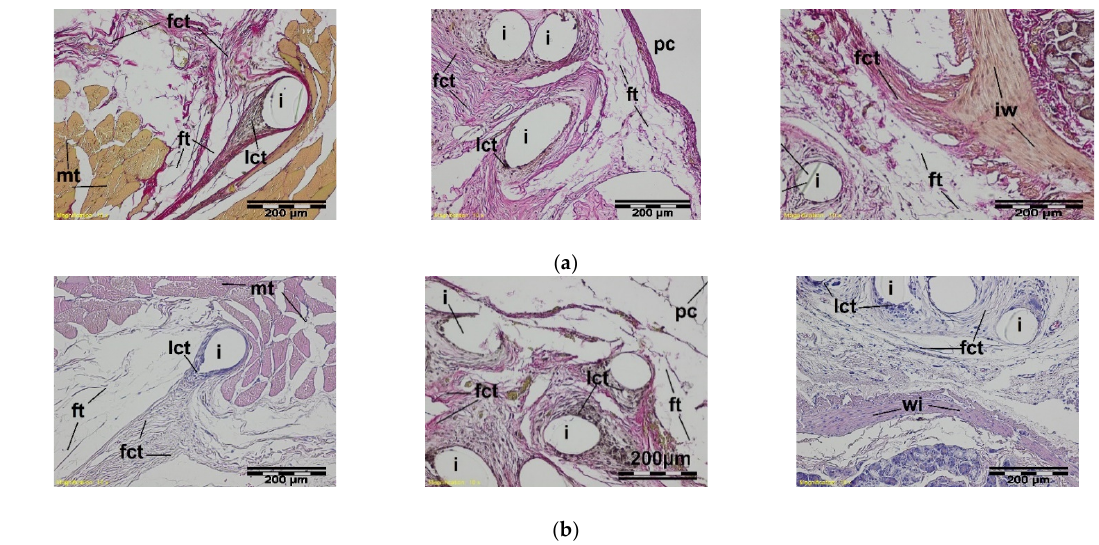
Figure 11. A microscopic view of the PACVD-modified implant ( a ) and reference ( b ) 12 weeks after the implantation in the abdominal wall of a NZW rabbit. Monofilaments of the knitted structure (i) are surrounded by connective tissue, which was fibrous (fct) from the muscles (mt) side and loose (lct) in the vicinity of the thread. On the right side, the adjacent intestinal wall (iw) is visible. Magnification, 100 × , Stain. VG and HE.